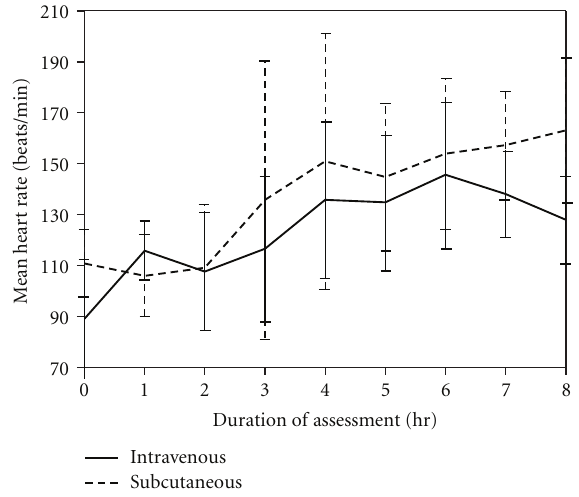
Figure 3: Mean heart rates over time are not significantly di ff erent between the IV and SC groups. Values within the IV group are significantly di ff erent from the baseline measurements at 4hr ( P = 0 . 02), 5hr ( P = 0 . 02), 6hr ( P = 0 . 00), 7 hr ( P = 0 . 001), and 8hr ( P = 0 . 009). Values within the SC group are significantly di ff erent from the baseline measurements at 4hr ( P = 0 . 042), 6hr ( P = 0 . 029), 7 hr ( P = 0 . 019), and 8 hr ( P = 0 .